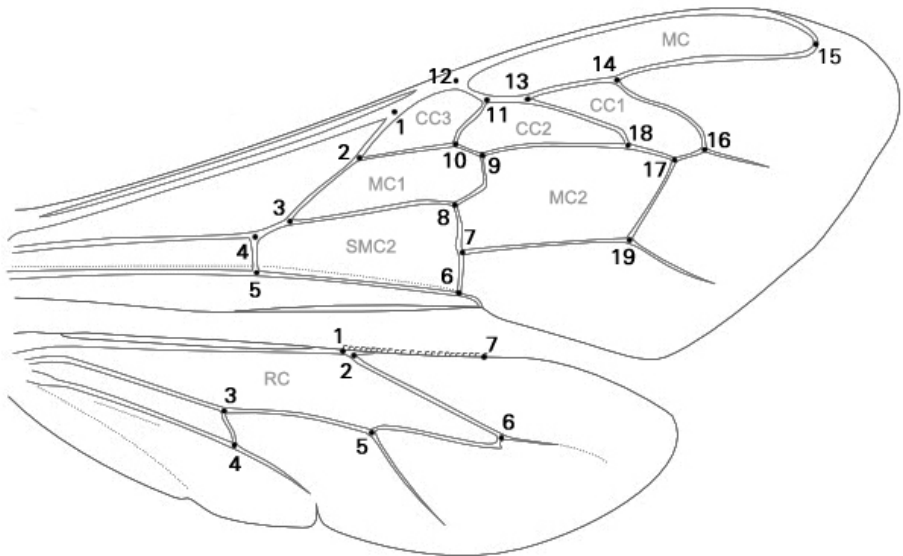
Figure 1. Location of the landmarks digitized on a right fore and hind wing of Apis mellifera workers (drawn to the same scale). MR: marginal cell, CC: cubital cell, MC: median cell, SMC: sub-median cell, and RC: radial